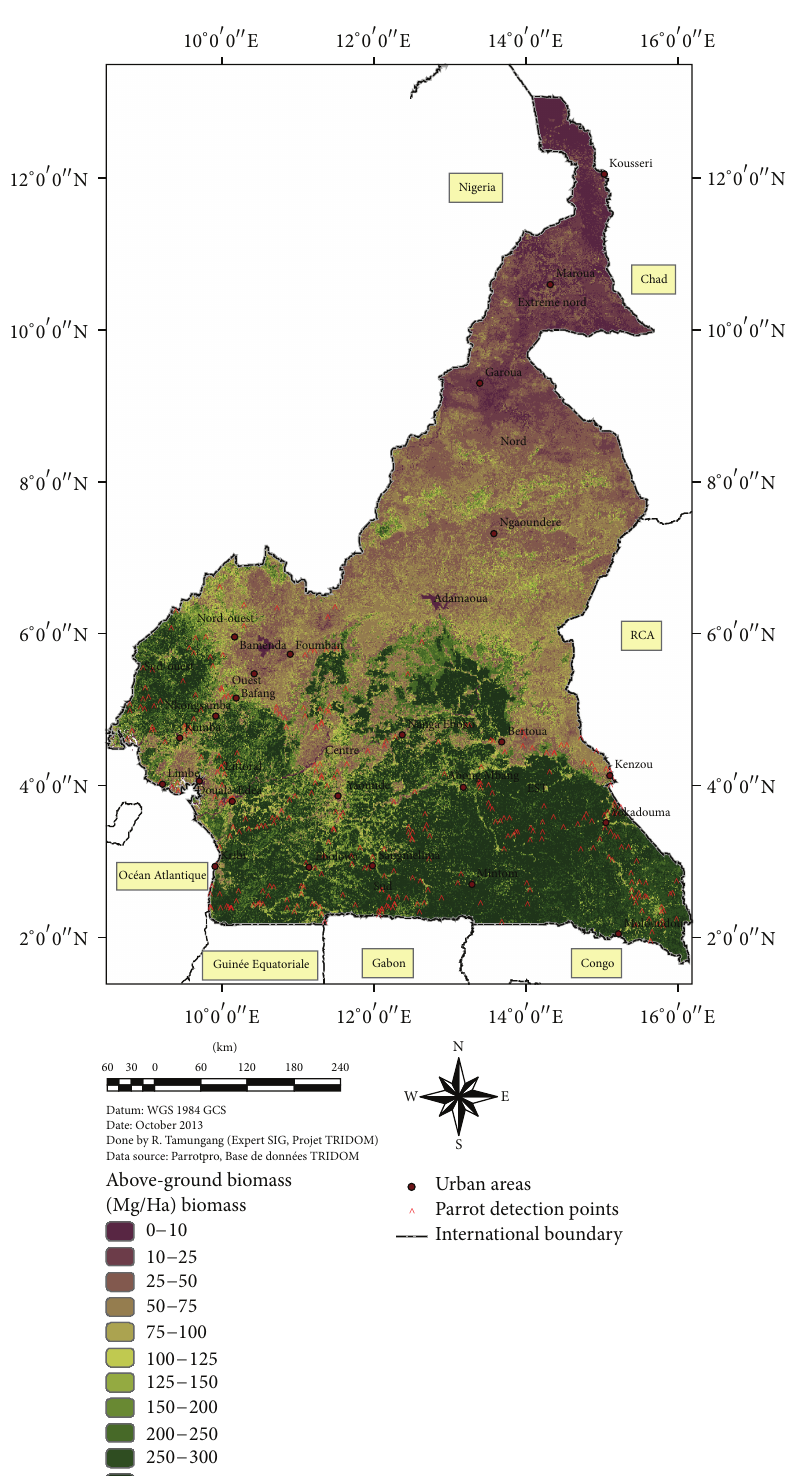
Figure 2: Current distribution of Grey Parrots in Cameroon in relation to parrot detection points and aboveground vegetation